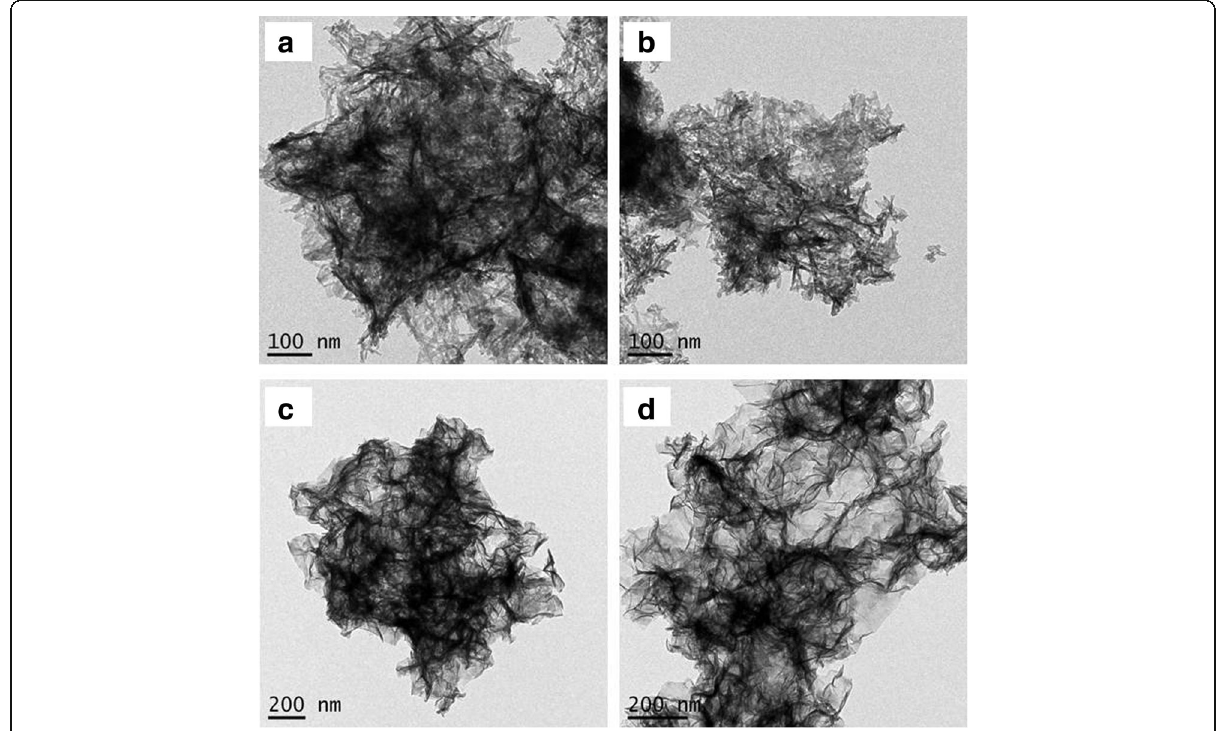
Fig. 2 TEM images of SA-Zn-HZ ( a , b ), SA-Zn 3 Al-HT ( c , d ) prepared at pH of